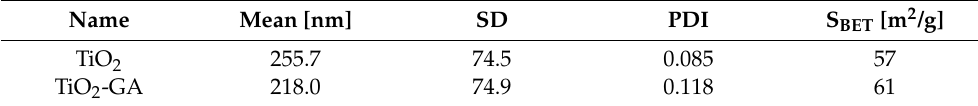
Table 3. Nanoparticle size measurements with NTA and BET surface area.